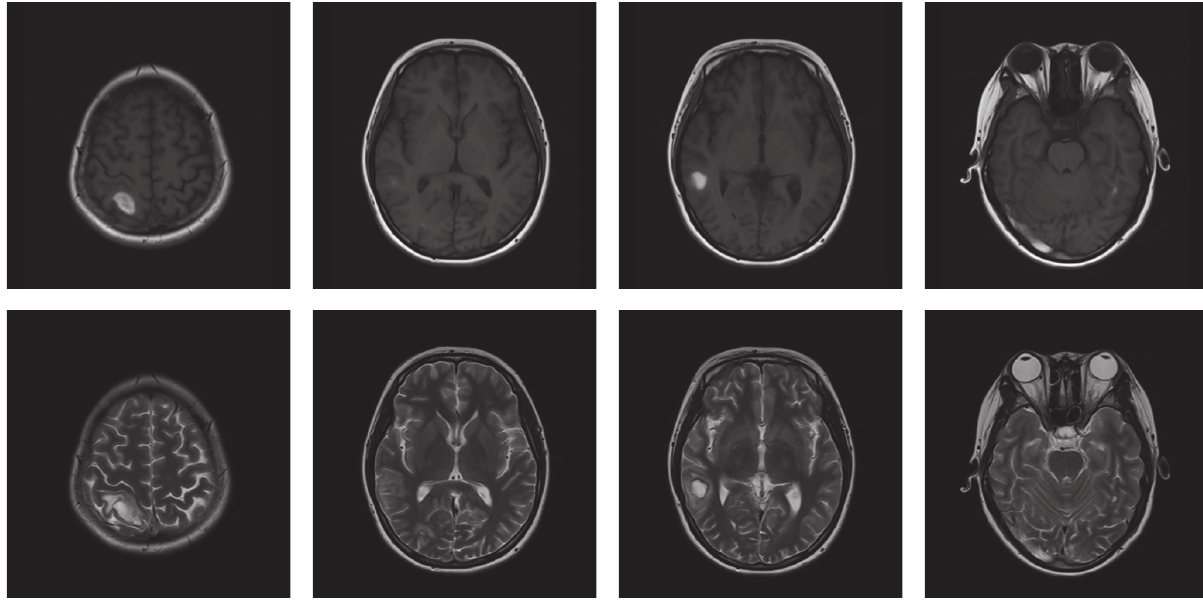
Figure 2: Hemorrhage of left temporal lobe, right parietal lobe, temporal lobe, occipital lobe, and right cerebellar hemisphere and suspicious thrombosis of sagittal sinus and right transverse